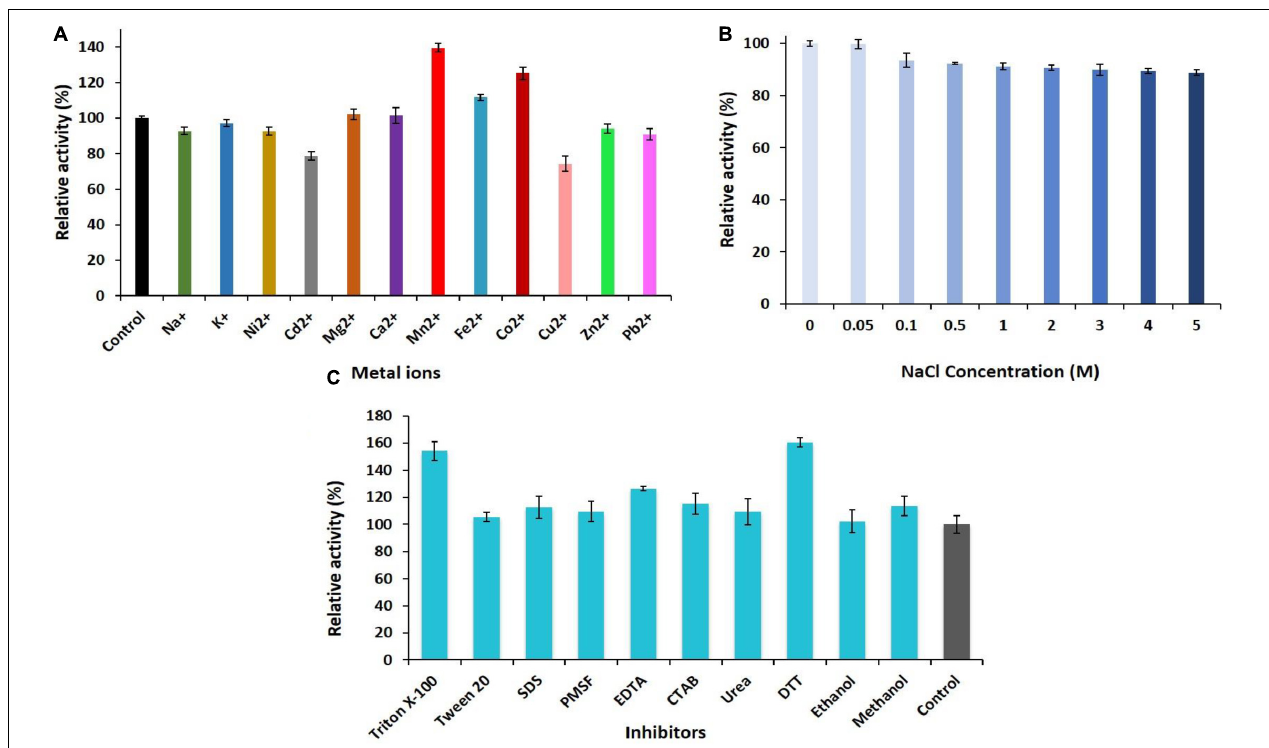
FIGURE 3 | (A) Effect of metal ions. (B) Various concentrations of NaCl (0–5 M). (C) Different concentrations of the inhibitors and surfactants on the activity of PersiAmy1.